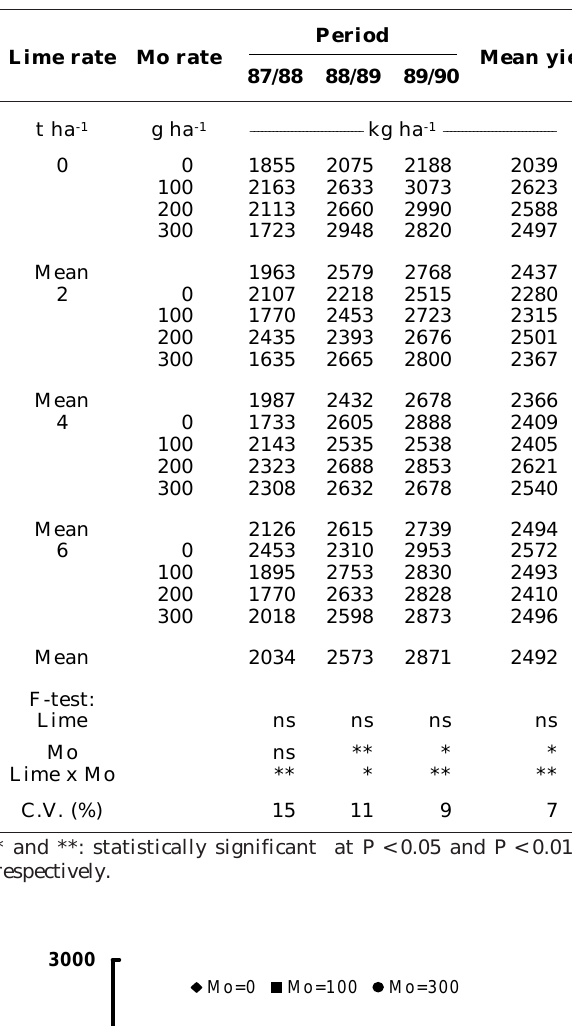
Table 2. Effect of lime and Mo and their interaction on peanuts